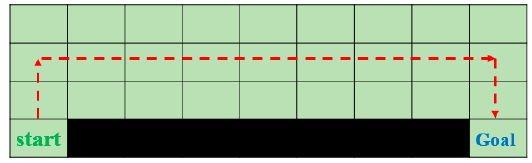
Figure 16. The SARSA algorithm route.